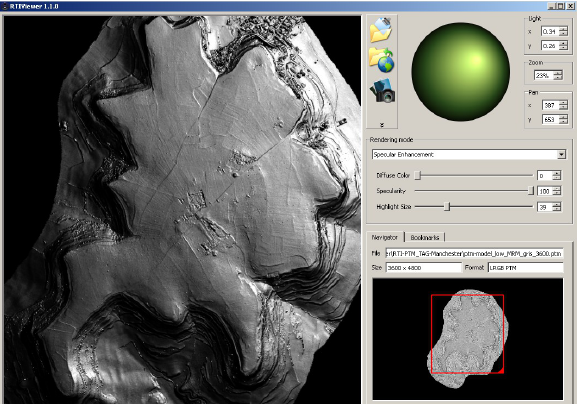
Figure 3: Results of the V-PTM applied to large sized models of earth surface: the Roman archaeological site of Clunia, Spain, (around 4 sq.